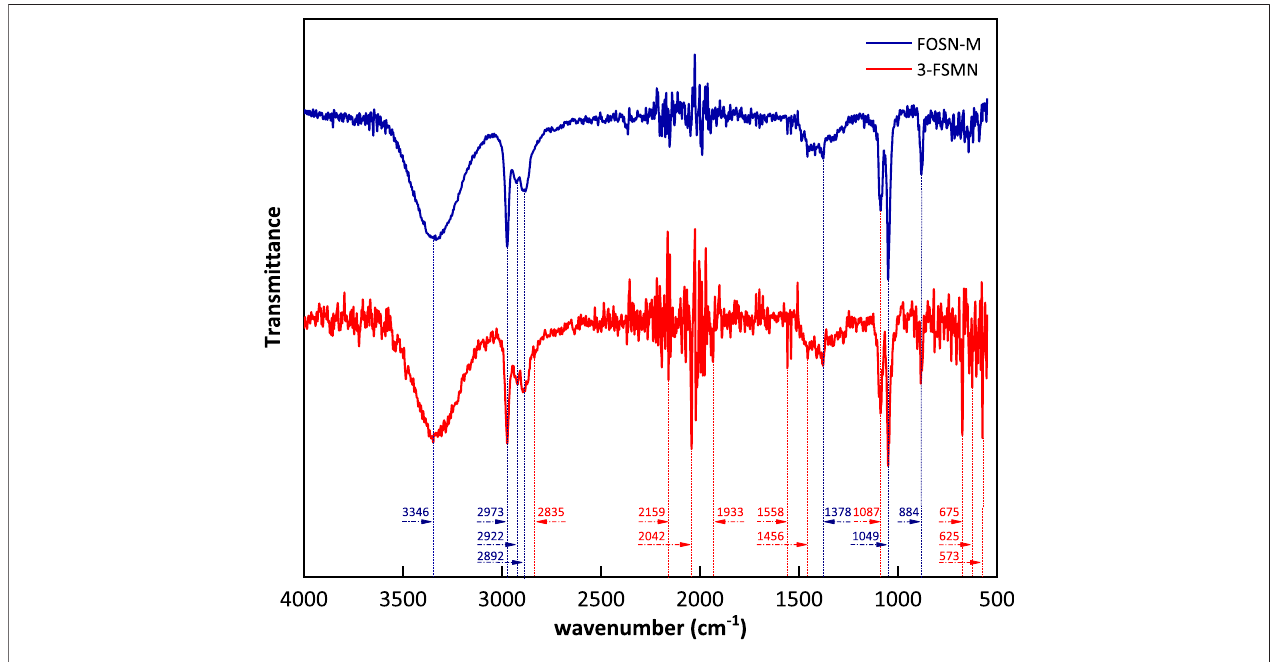
FIGURE 4 | Infrared absorption spectra of FOSN-M and